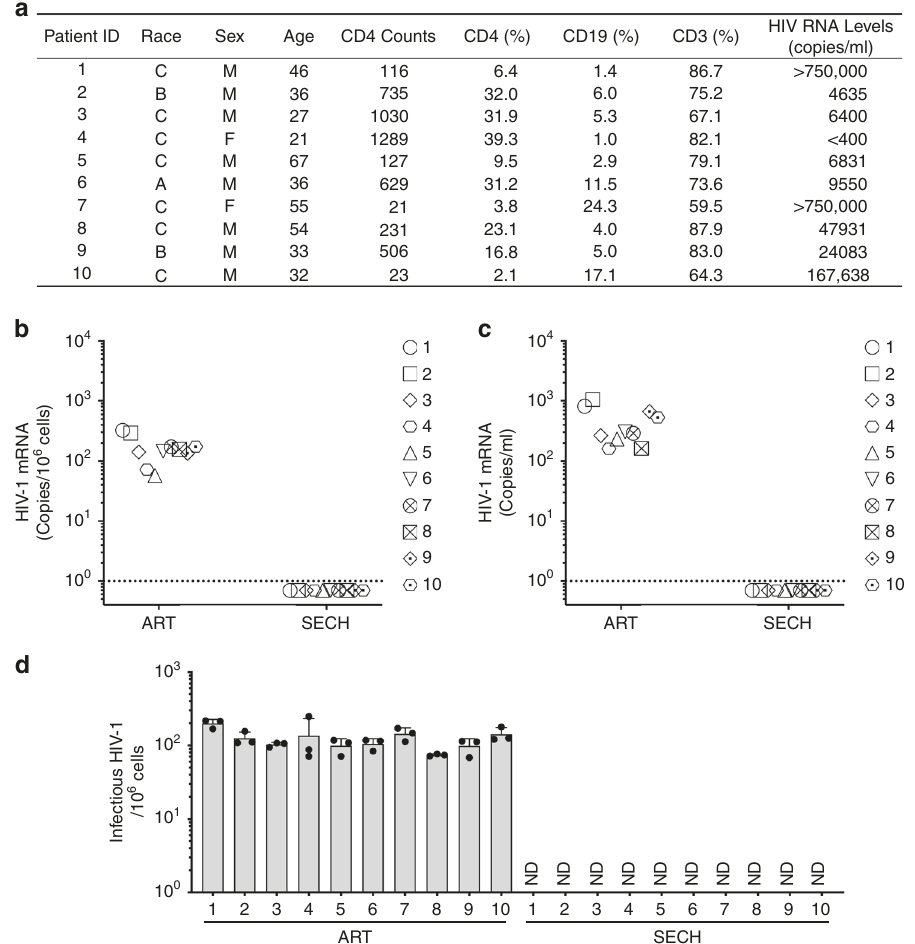
Fig. 6 Clearance of HIV-1-infected cells from ART-naive HIV-1 patients by SECH treatments in vitro. a CD4 counts and HIV-1 load in ART-naive HIV-1- infected patients ( n = 10) without previous antiretroviral treatment. A, Asian; B, Black; C, Caucasian. b PBMCs obtained from ART-naive HIV-1 patients ( n = 10) were culture in vitro with agents for SECH or ART only for 2 days as on cycle, with a total of seven cycles as described in the “ Method ” section. Samples were also re-stimulated with IDB for detection of HIV-1 mRNA by RT-PCR. The dash line indicates detection limit. c PBMCs treated by in b were depleted of CD8 + T cells and 3 × 10 6 cells were adoptively transferred into uninfected Hu-HSC mice for detection of HIV-1 by hmVOA. d The cells treated in b were used for TZA analyses. Ten biological samples were each measured in three technical replicates and presented as mean ± SD. Source data are provided as a Source Data fi